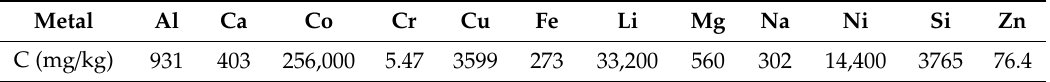
Table 2. Quantitative–qualitative composition of paramagnetic fraction originating from spent Li-ion batteries.